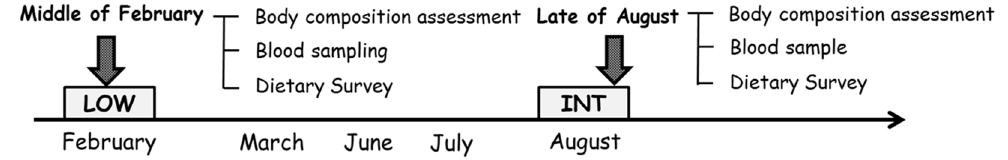
Figure 1. Experimental design during LOW and INT.